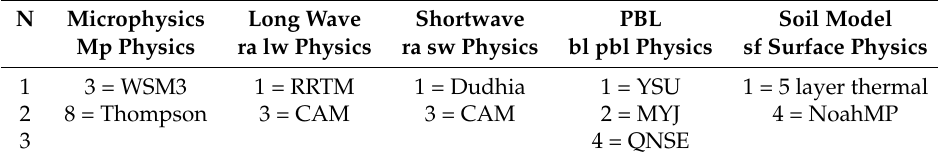
Table 2. Weather Research Forecast (WRF) Namelist Input Physics Options. N